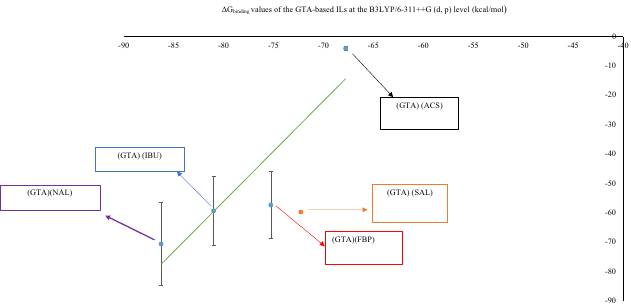
Figure 9. Correlation between ΔG binding (kcal mol −1 ) from 20 ns of MD simulation and ΔE int (kcal mol −1 ) from